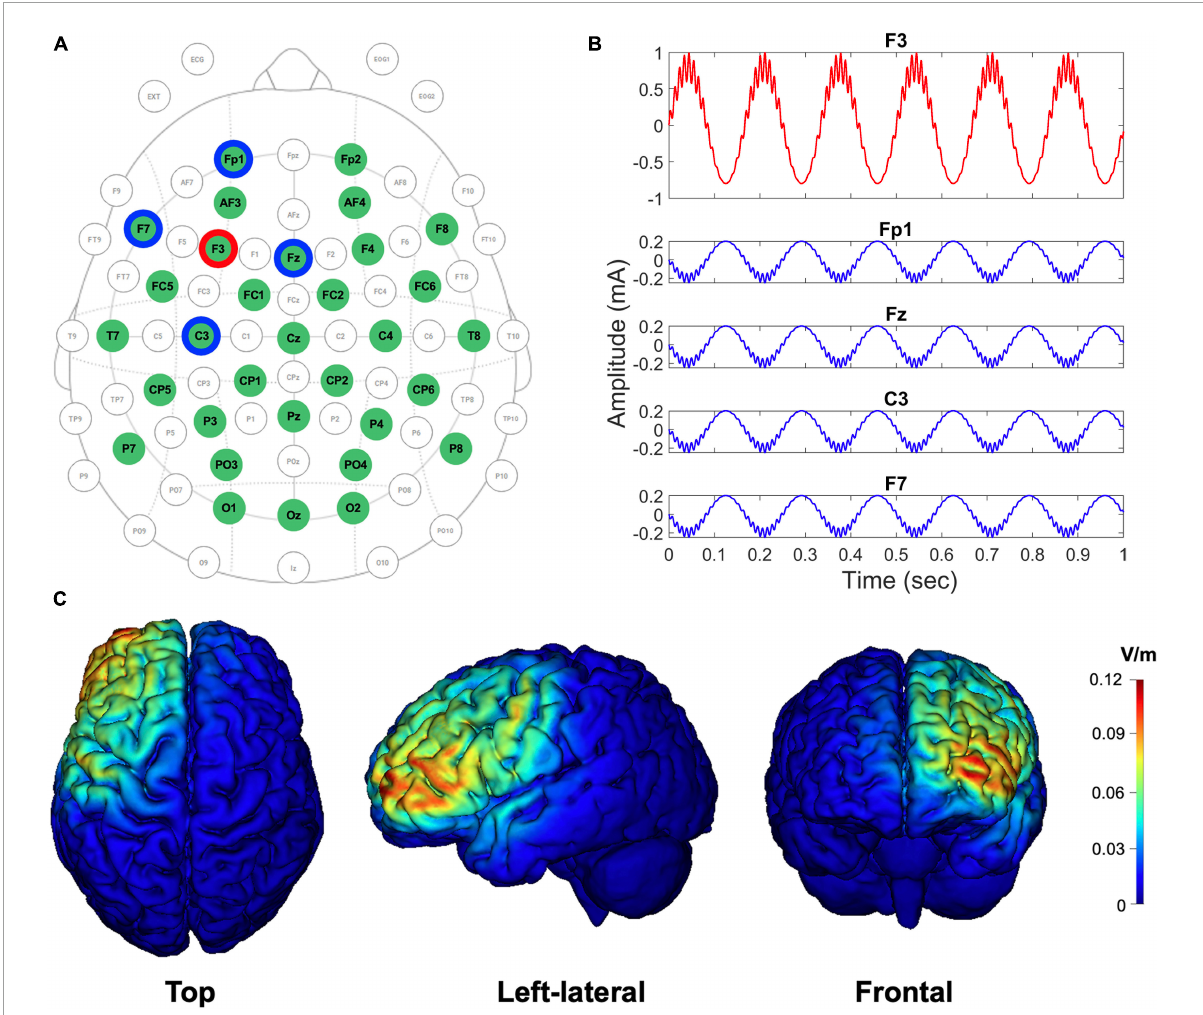
FIGURE2 EEG-tACS 32-channel configuration, the shape of the CFC-tACS stimulus, and tACS cortical target areas by simulation. (A) EEG and tACS channel montage. The red ring indicates a stimulation channel of F3, and its four surrounding return channels (i.e., Fp1, Fz, F7, and C3) are highlighted in blue rings. Using the remaining channels in the green circles, the EEG signals were recorded. The topographical view is from the vertex, with the nose at the top of the image. (B) The shapes of theta-phase/high-gamma-amplitude coupled tACS stimulus (1.8 mA peak-to-peak). The form of an input CFC-tACS stimulus (red curve) is illustrated in F3, and the sum of the remaining four return signals (blue curves) has the same amplitude as the F3 input signal, but with its reverse polarity and in anti-phase to disperse the return current effects. (C) The cortical-level tACS target (i.e., left prefrontal) areas are simulated using the scalp-level tACS electrode configuration. Top, left-lateral, and frontal views of cortical maps are illustrated from left to right. Color scales indicate the intracranial electric field (V/m), with high intensity in red and low intensity in